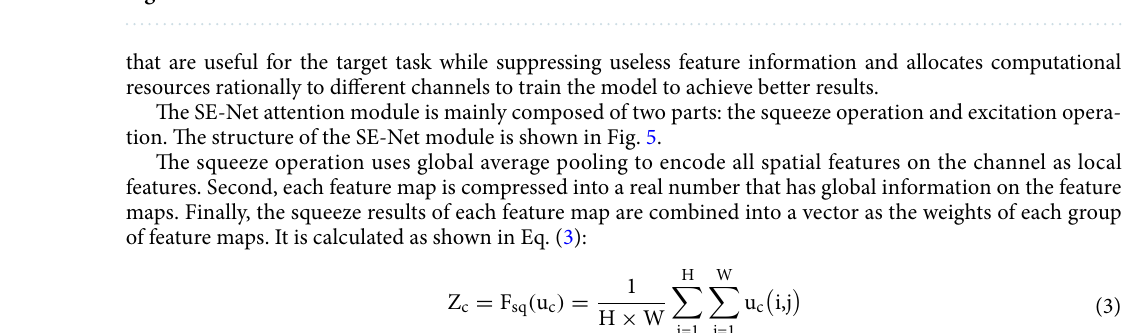
Figure 6. The YOLOv5s-STD network